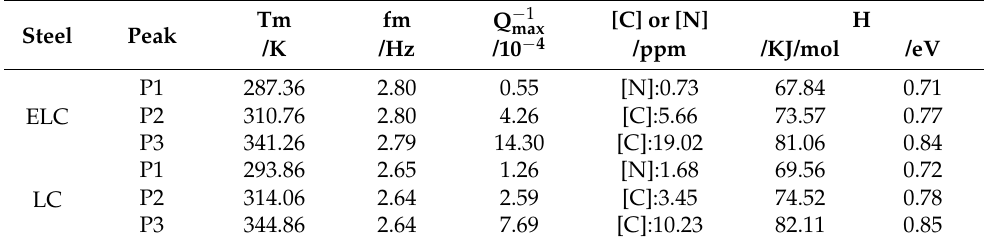
Table 4. Important indexes characterizing the internal friction peaks of different C content.